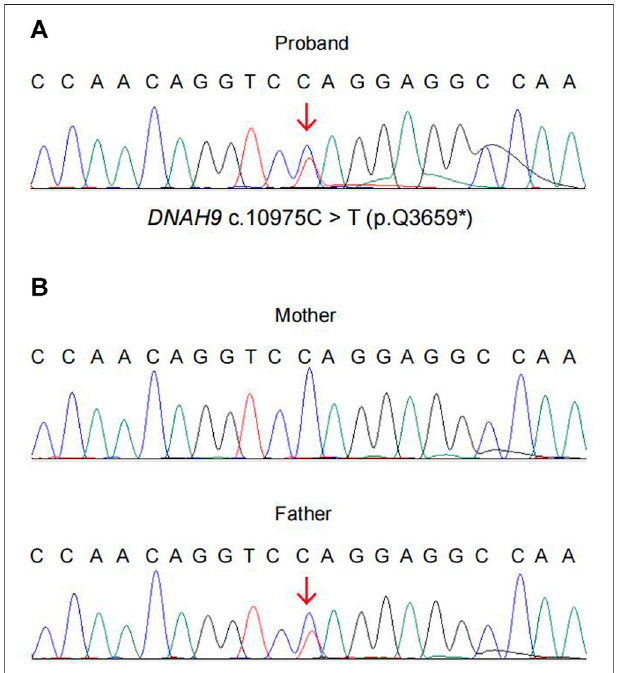
FIGURE 3 | The evidence of the heterozygous nonsense mutation c.10975C > T (p.Q3659*) in the DNAH9 gene. WES and sanger sequencing veri fi ed the heterozygous mutation DNAH9 c.10975C > T in the proband (A) and her parents (B) .